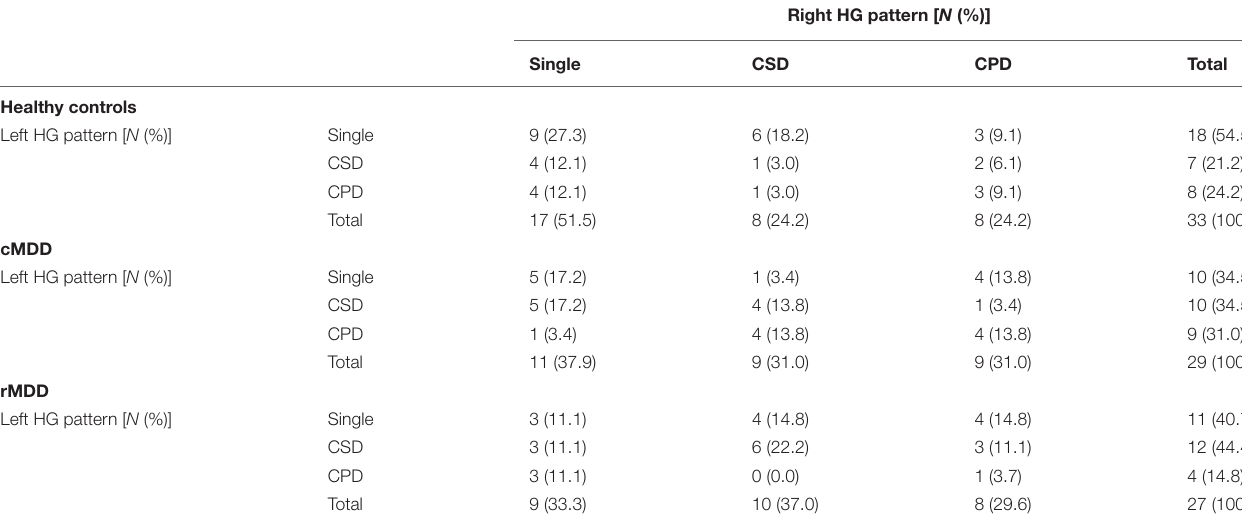
TABLE 3 | Gyrification pattern of Heschl’s gyrus (HG) for both hemispheres in the major depressive disorder (MDD) cohort.